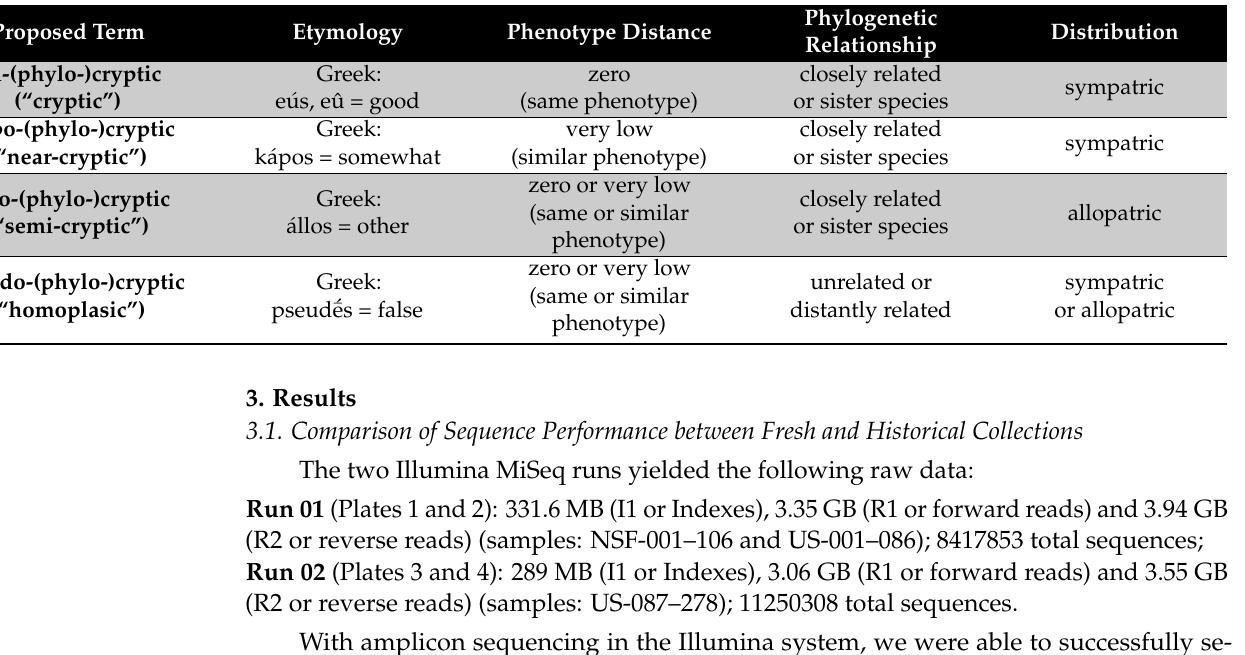
Table 2. Definition of different types of crypticity within an evolutionary context and the correspond- ing terms used in other studies [34].